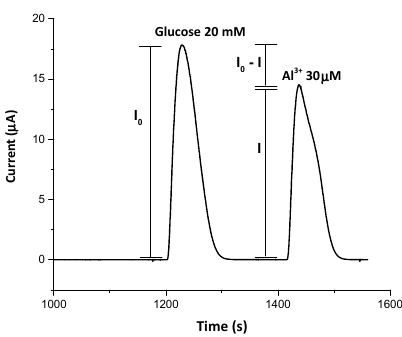
Figure 2. FIA peaks recorded for glucose (20 mM) and in presence of 30 µM of Al 3+ ions prepared in acetate buffer (0.05 M, pH = 5.2). Experimental conditions as in Figure 1.